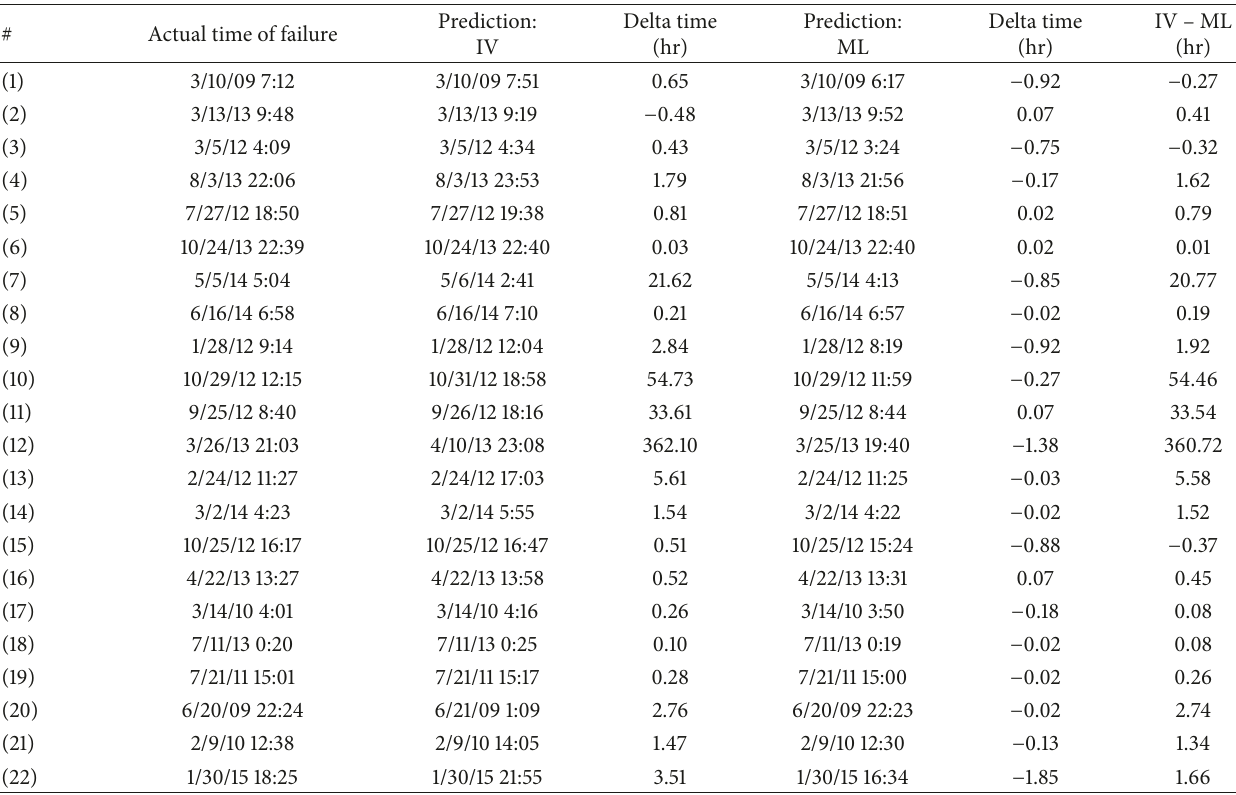
Table 2: Results of the comparison between inverse velocity (IV) method and machine learning (ML) method from 22 different failure examples.